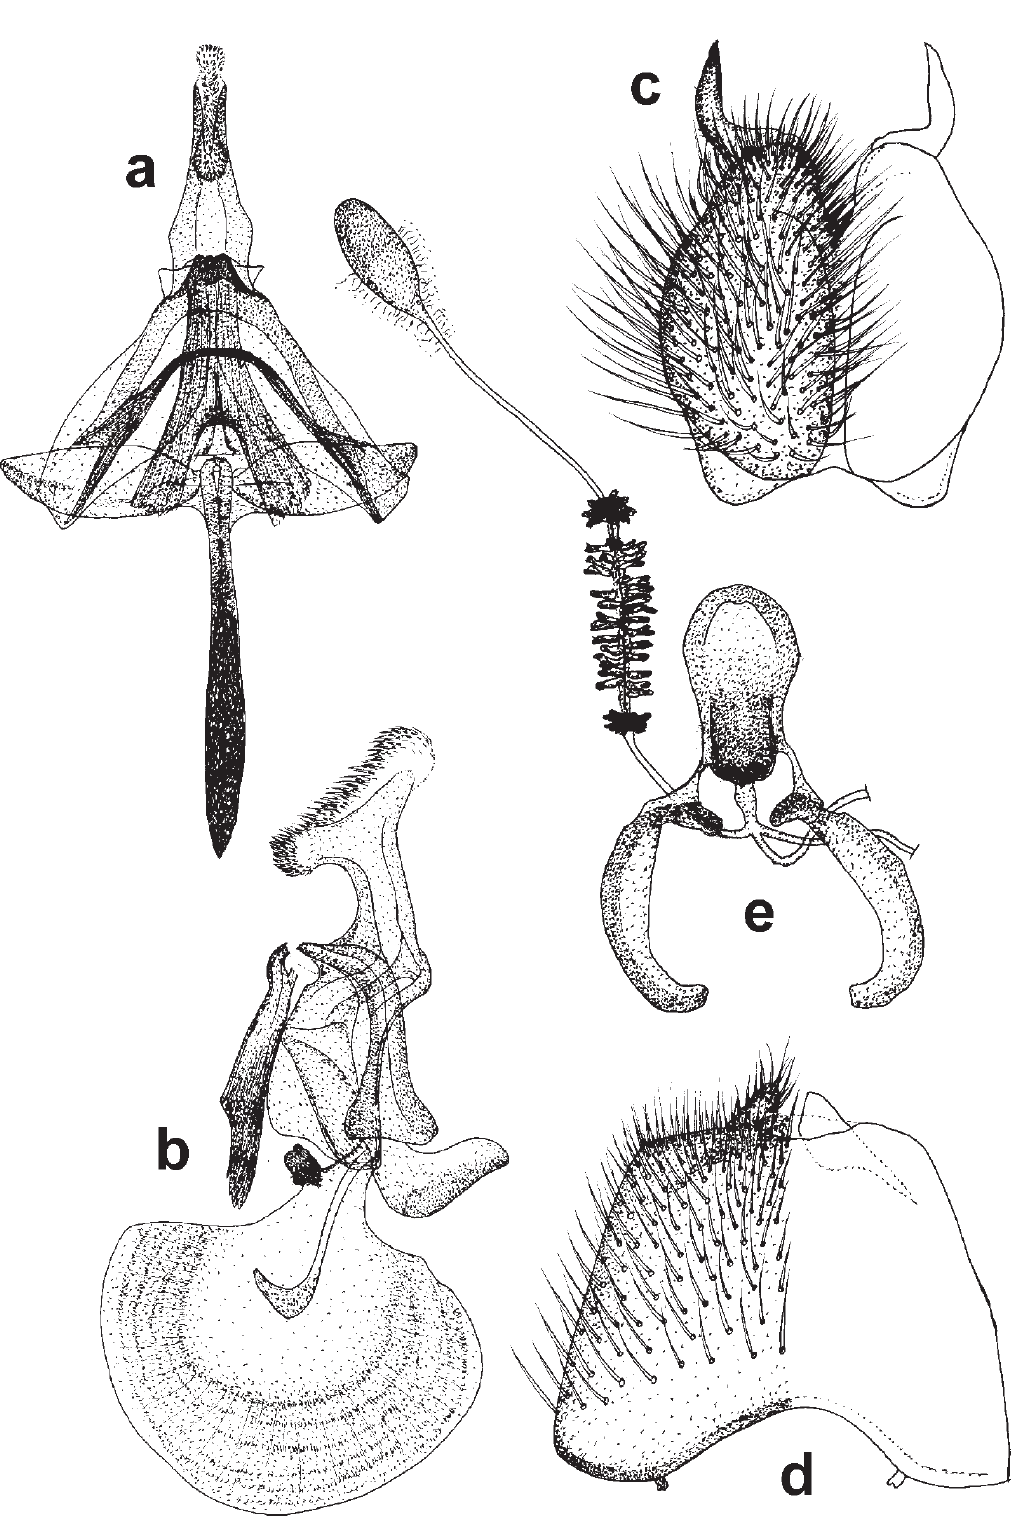
Fig. 66. Parusia propinqua gen. et sp. nov. a . Epiphallic complex ventral. b . Epiphallic complex lateral. c . Gonocoxite ventral. d . Epandrium dorsal. e . Female genitalia